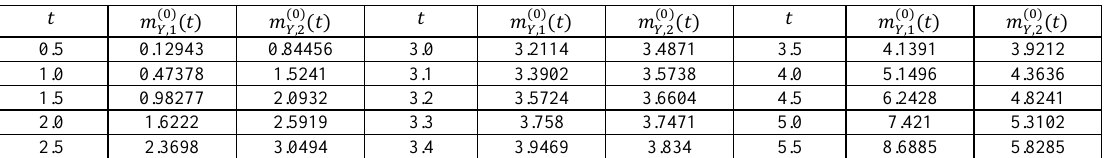
Table 2. Two mutation: comparison of growth of intermediate